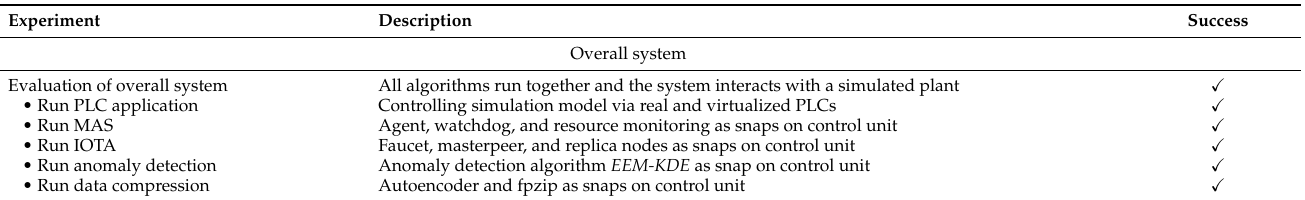
Table 4. Conducted